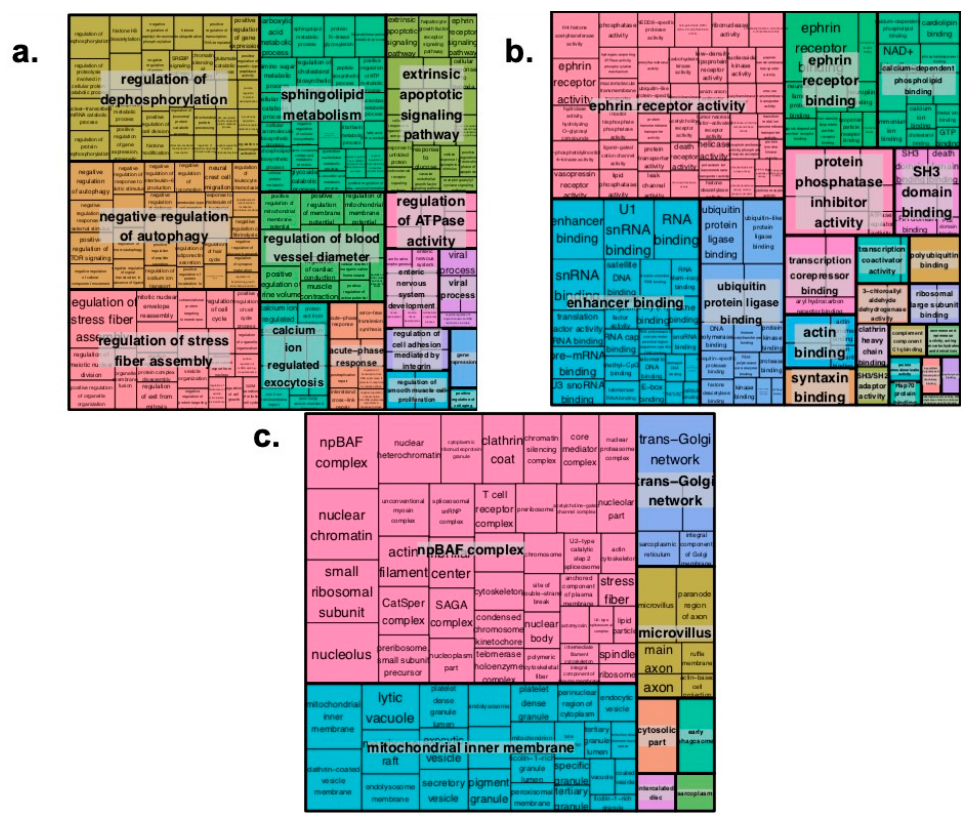
Figure 3. Pathway enrichment analysis performed using software Enrichr on 169 genes regulated by enhancers.